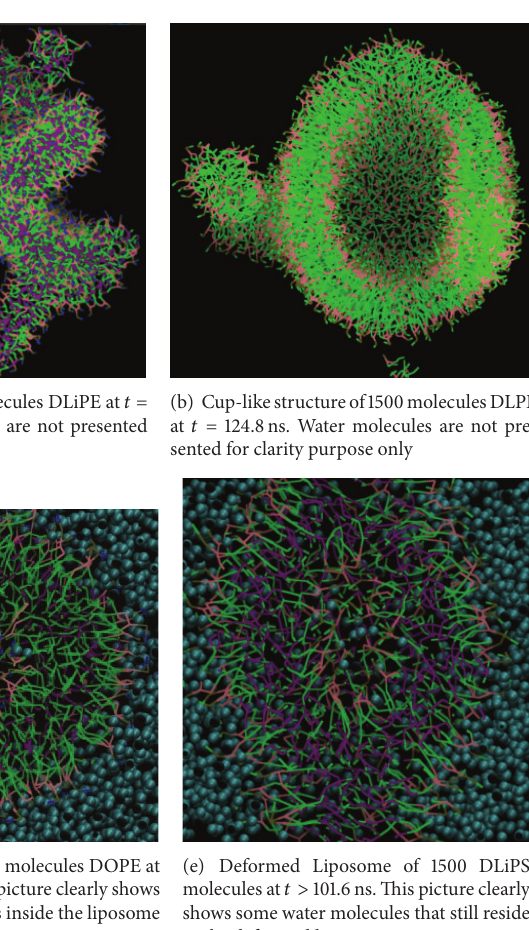
is represented by the aggregation of 256 DOPE